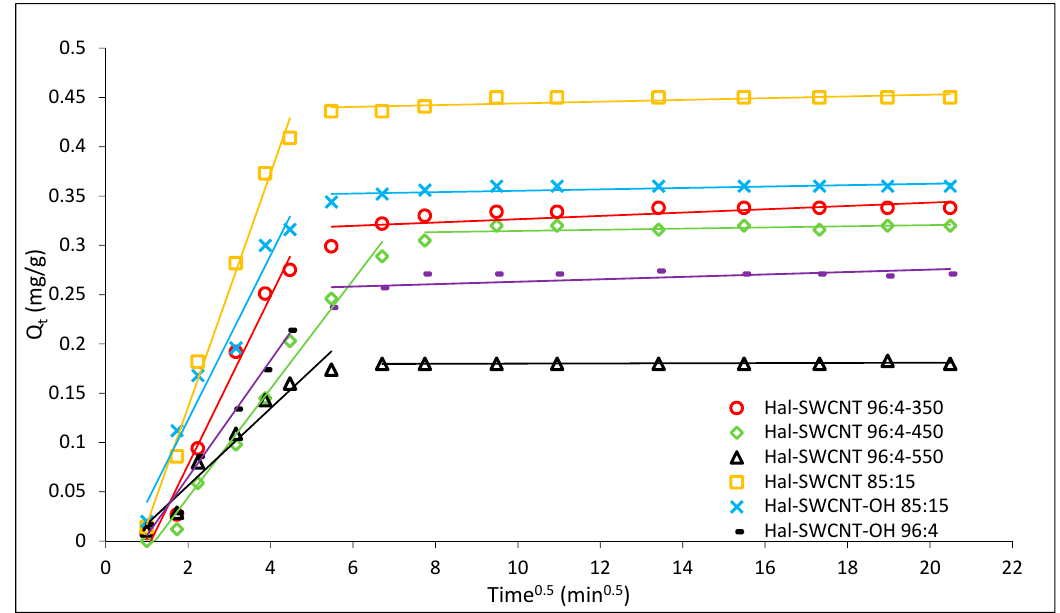
Figure 9. Interparticle diffusion plots for adsorption of ANT on Hal-CNT composites.